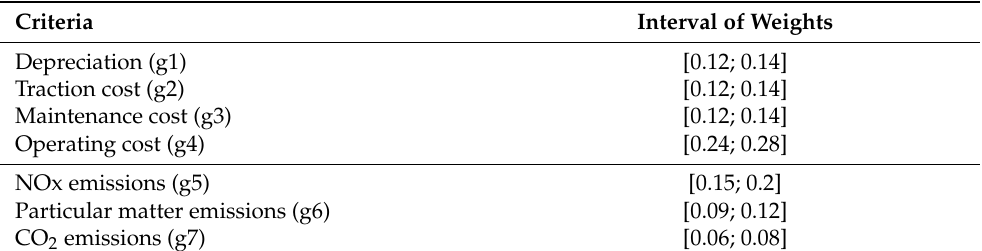
Table 18. Variation ranges of the criteria weights considering that the economic criteria have 70% of the total importance.